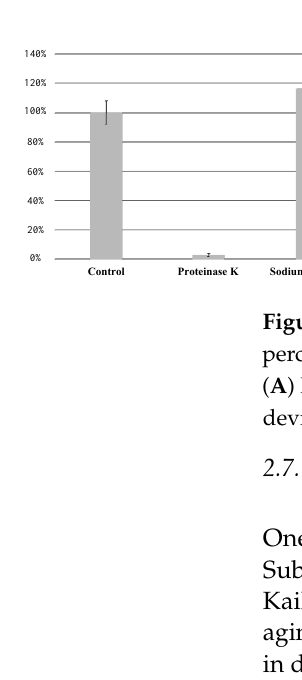
teins or sugar derivatives, host strain M. foliorum NRRL B-24224 was treated with either